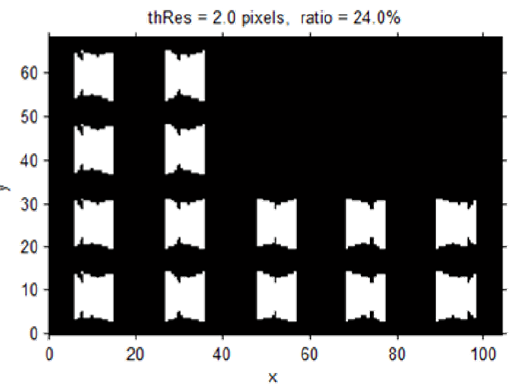
Figure 7. Areas with a surveillance resolution greater than or equal to 2 px/cm when objects are on the bottom and their orientations are upper vertical (white: resolution ≥ 2 px/cm; black: resolution < 2 px/cm).